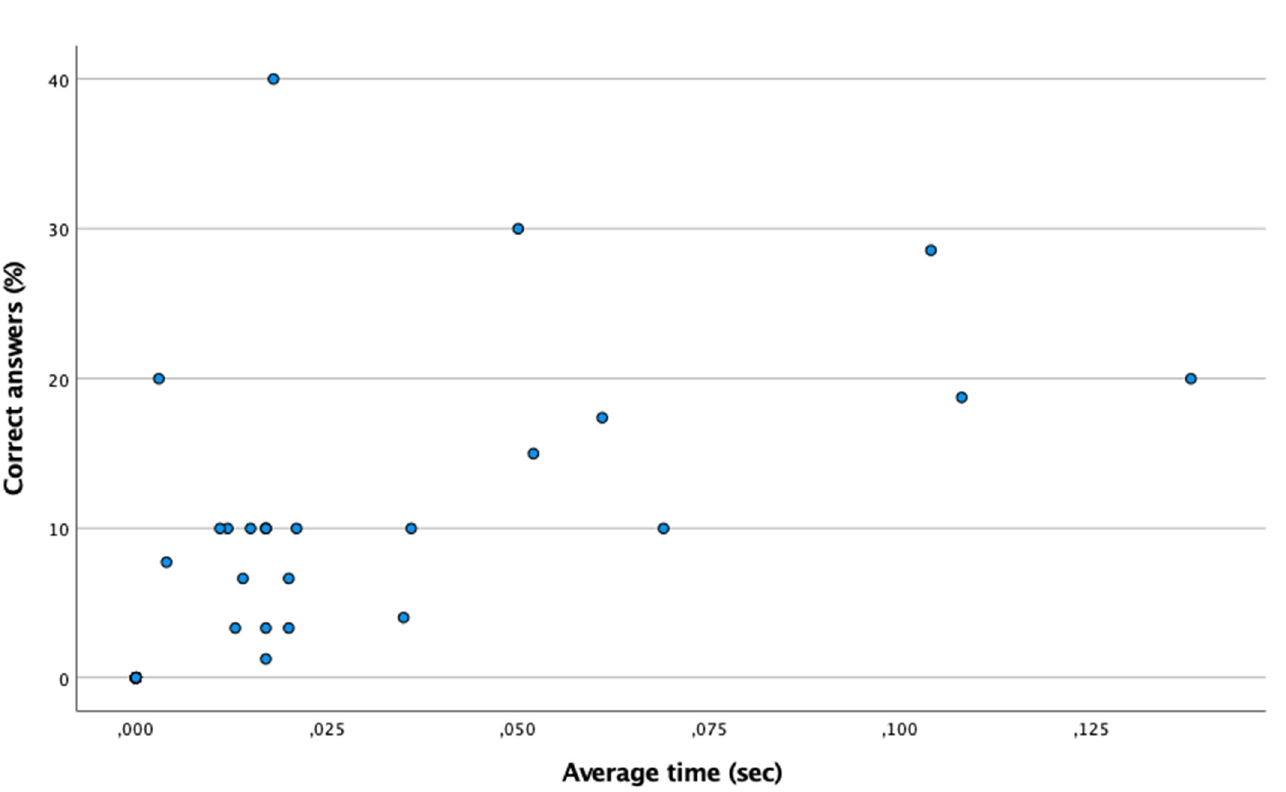
Table 1. Results of Anticipation time test.